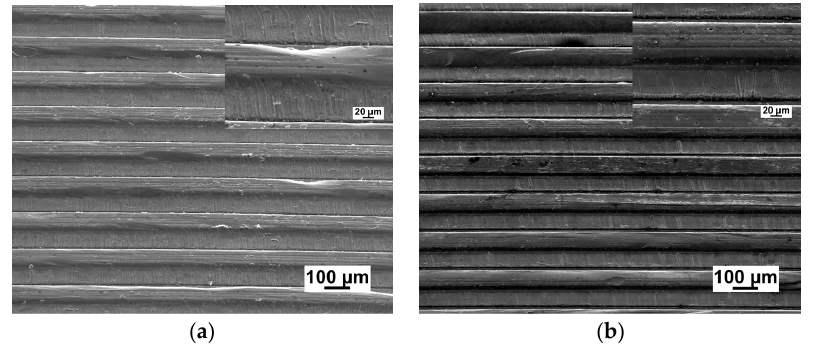
Figure 9. The comparison images of micro-channels on different materials: ( a ) CG LZ91 Mg-Li alloy; ( b ) UFG LZ91 Mg-Li alloy.